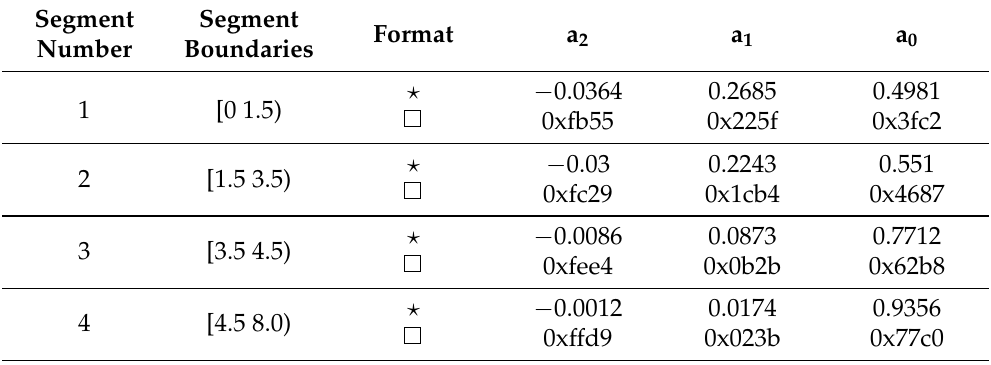
Table 3. Floating-point and fixed-point coefficients for implementing Sigmoid AF in HNN.